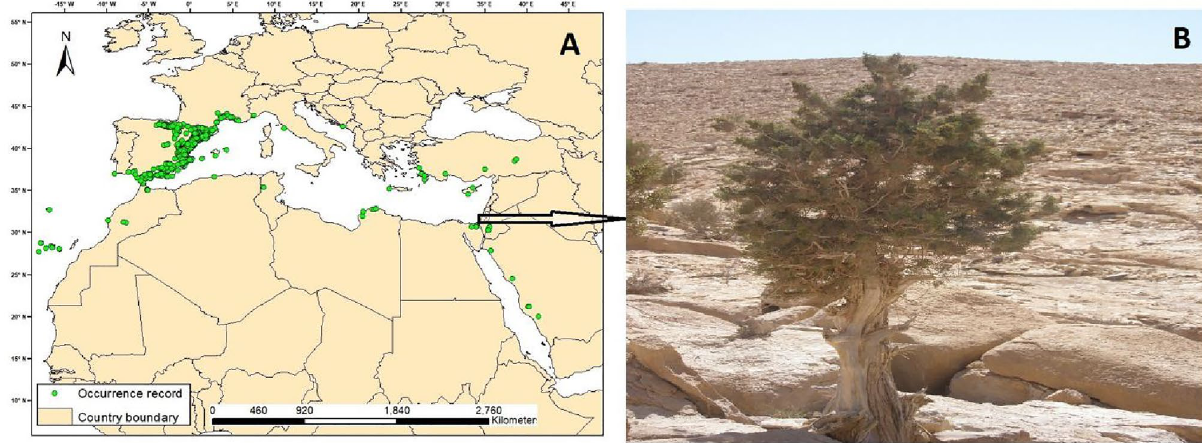
Figure 1. Global distribution map of Juniperus pheonicea generated in ArcGIS 10.5 ( A ) and a growing plant at a dry, rocky habitat in north Sinai (Egypt) ( B